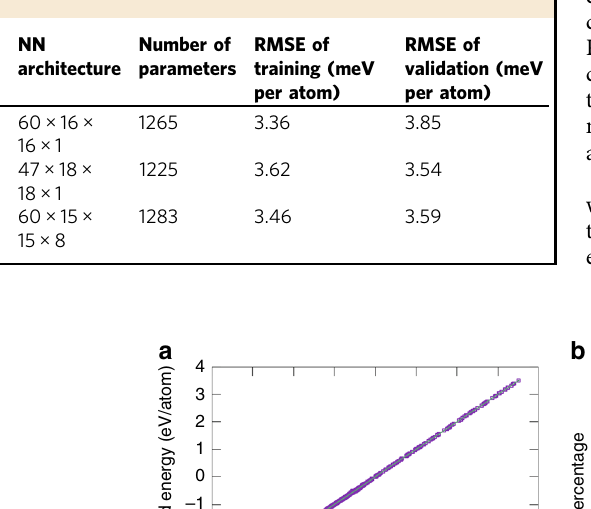
Table 1 Fitting and validation errors of the straight NN and PINN models